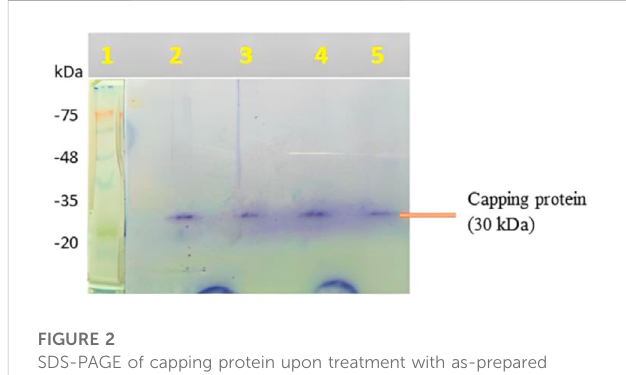
FIGURE 2 SDS-PAGE of capping protein upon treatment with as-prepared